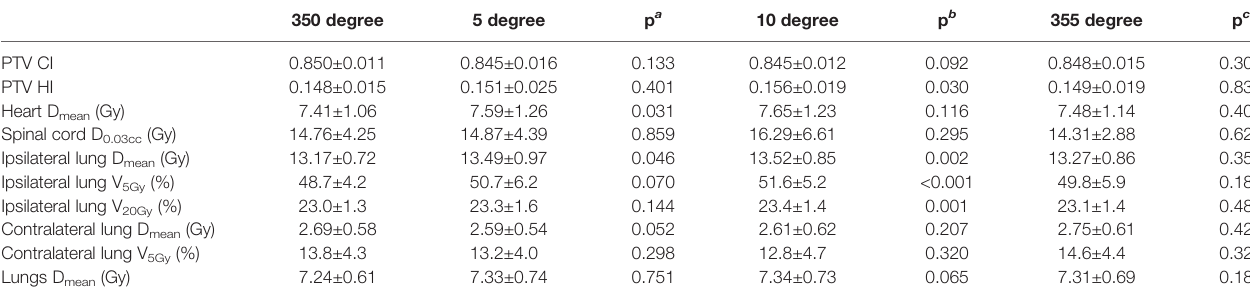
TABLE 5 | Dosimetric results (mean ± standard deviation) of left-sided postmastectomy VMAT plans with different collimation